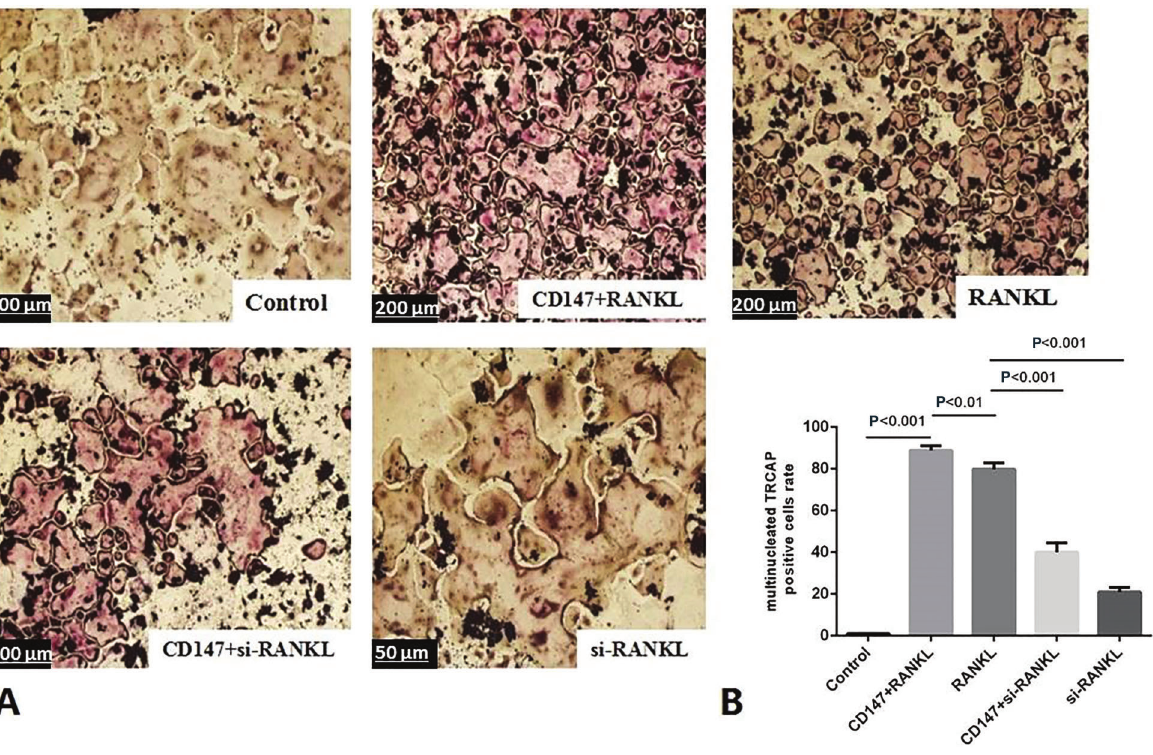
Figure 2. A , Tartrate-resistant acid phosphatase (TRACP)-positive osteoclast formation in mice that received different treatments. TRACP. B , Multinucleated TRACP positive cells per group, compared with the t -test. Data are reported as means ± SD. RANKL: receptor activator of NF- k B